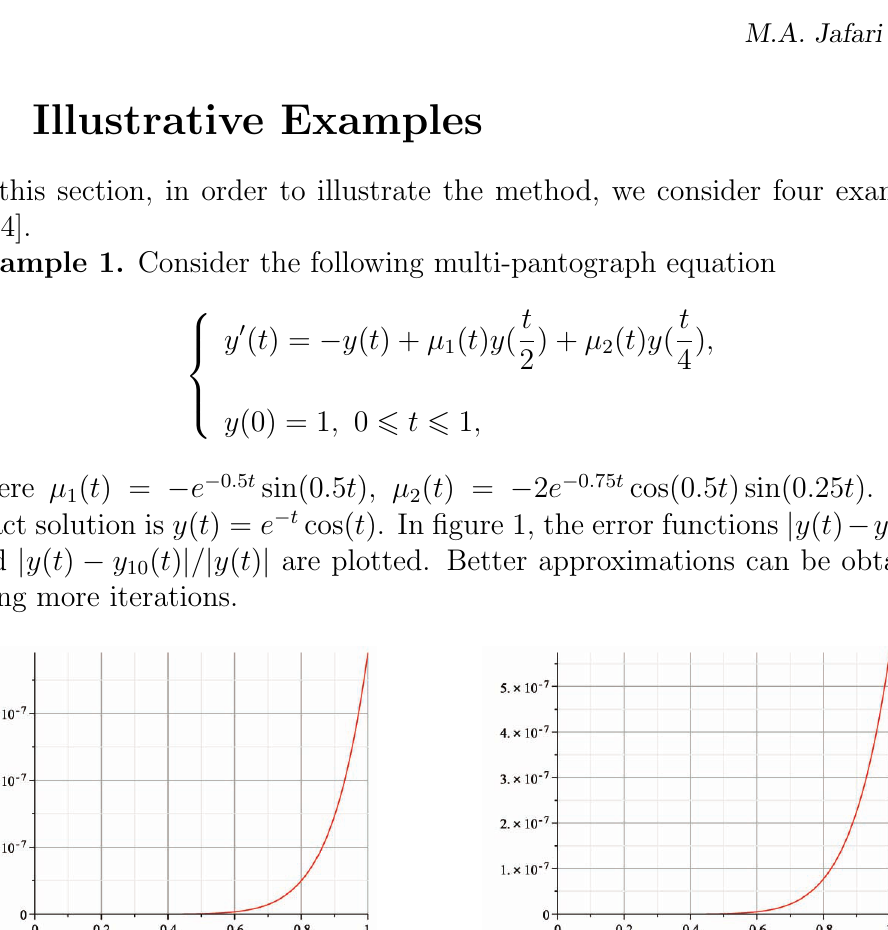
Figure 1: Plot of the | y ( t ) − y